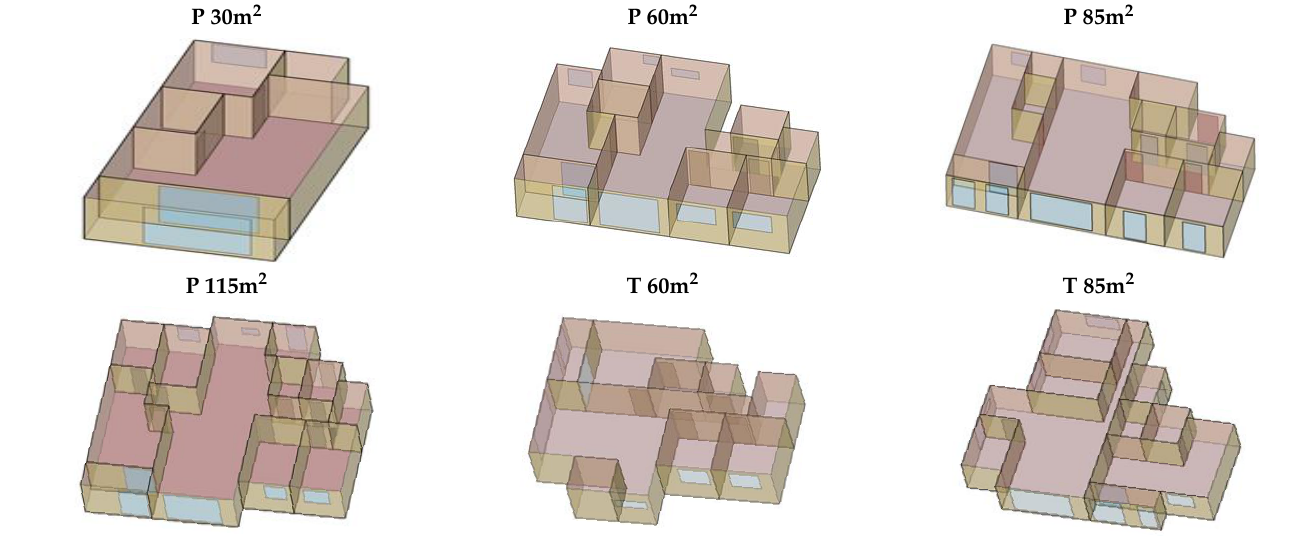
Table 2. Default input values for Energyplus simulation.